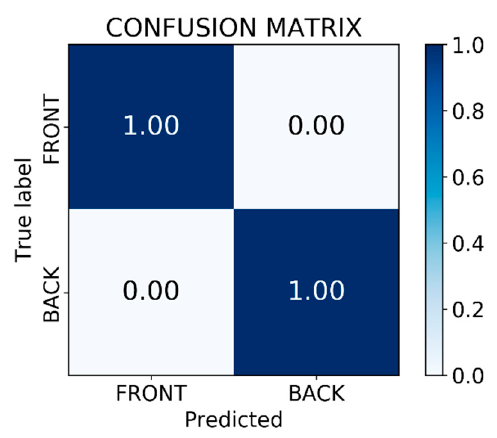
Figure 19. ( a , c ) Ground truth of two test cases; ( b , d ) the results of the prediction corresponded to two ground truths.